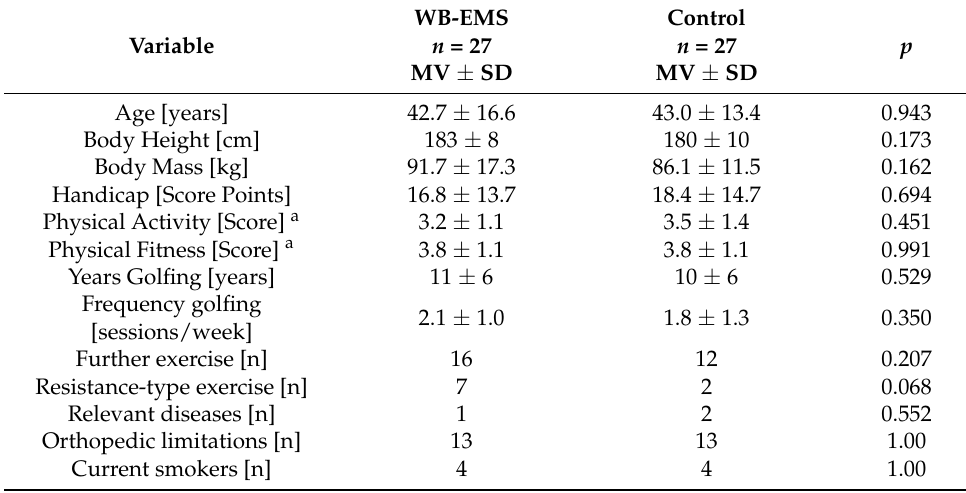
Figure 1. Participant flow through the FrEMGo study. Table 1. Baseline characteristics of the WB-EMS and control group.